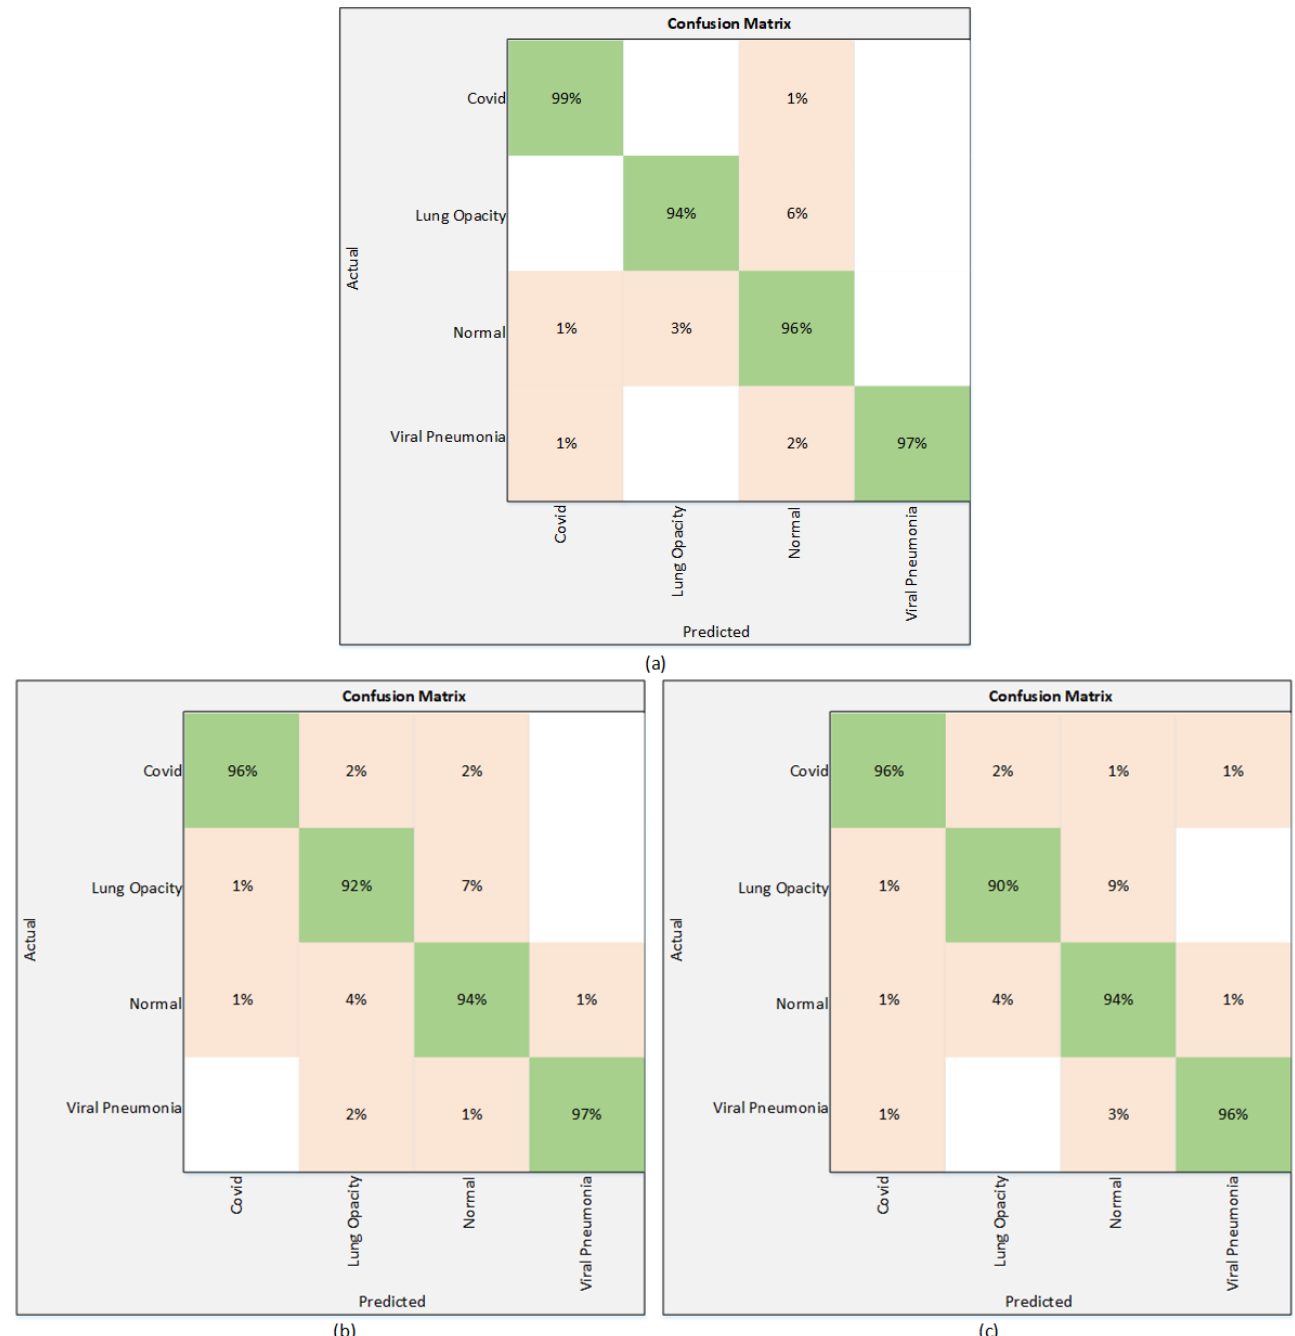
Figure 6. Confusion matrix using Strategy II. ( a ) EfficientNetB1 ( b ) NasNetMobile ( c ) Mo-